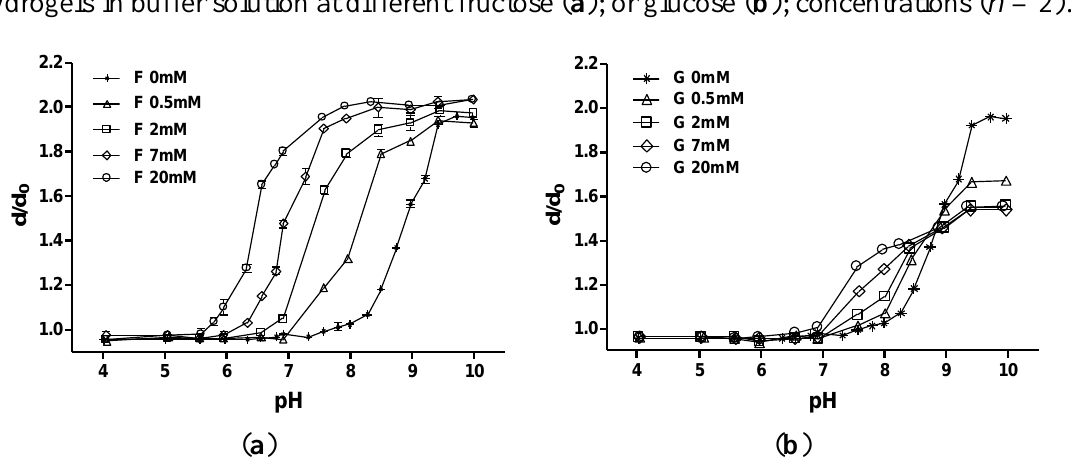
Figure 4. Equilibrium swelling of methacrylamidophenylboronic acid (MPBA)- co